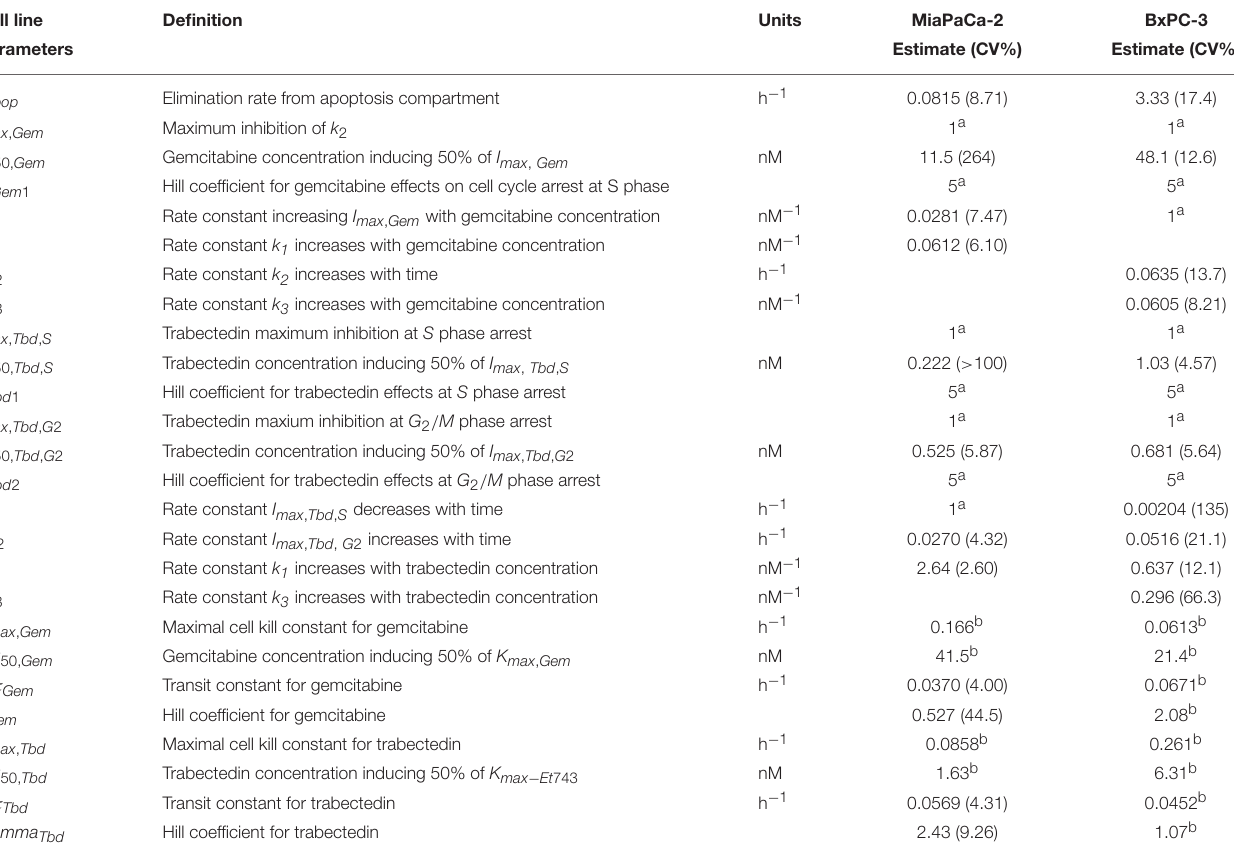
TABLE 3 | Pharmacodynamic model parameter estimates. Parameters were obtained after fitting to cell cycle models for either gemcitabine (Figures 1C,D) or trabectedin (Figure 1E) as single agents. Cell line